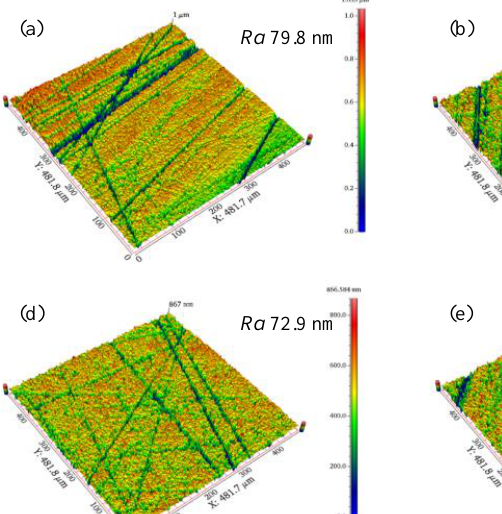
Figure 12. Micrographs and 3D micro-topography images of flank face. ( a ) initial, Ra 163.1 nm, ( b )